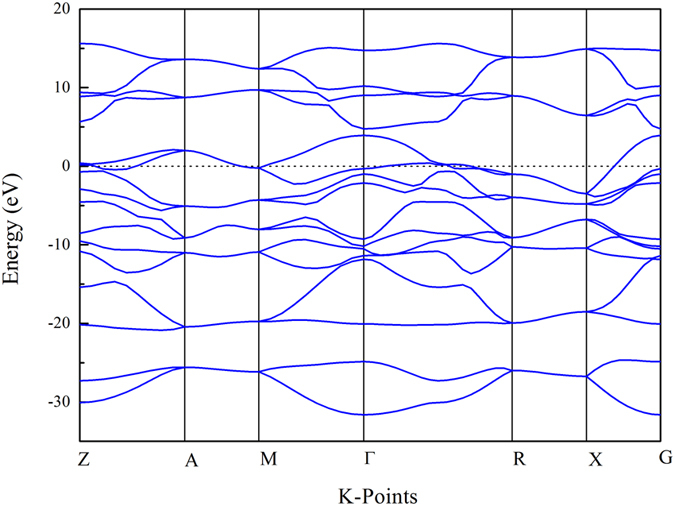
Band structure of P21/m NO at 198 GPa. Z(0,0,0.5), A(0.5,0.5,0.5), M(0.5,0.5,0), G(0,0,0), R(0,0.5,0.5) and X(0,0.5,0).